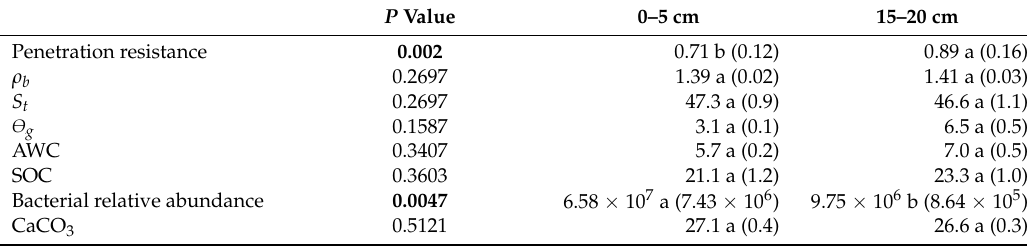
Table 1. Treatment effect on the soil surface roughness (%), penetration resistance (MPa), bulk Table 2. Depth effect on the soil penetration resistance (MPa), bulk density ( ρ b : g cm − 3 ), total porosity ( S t , %), gravimetric moisture content (